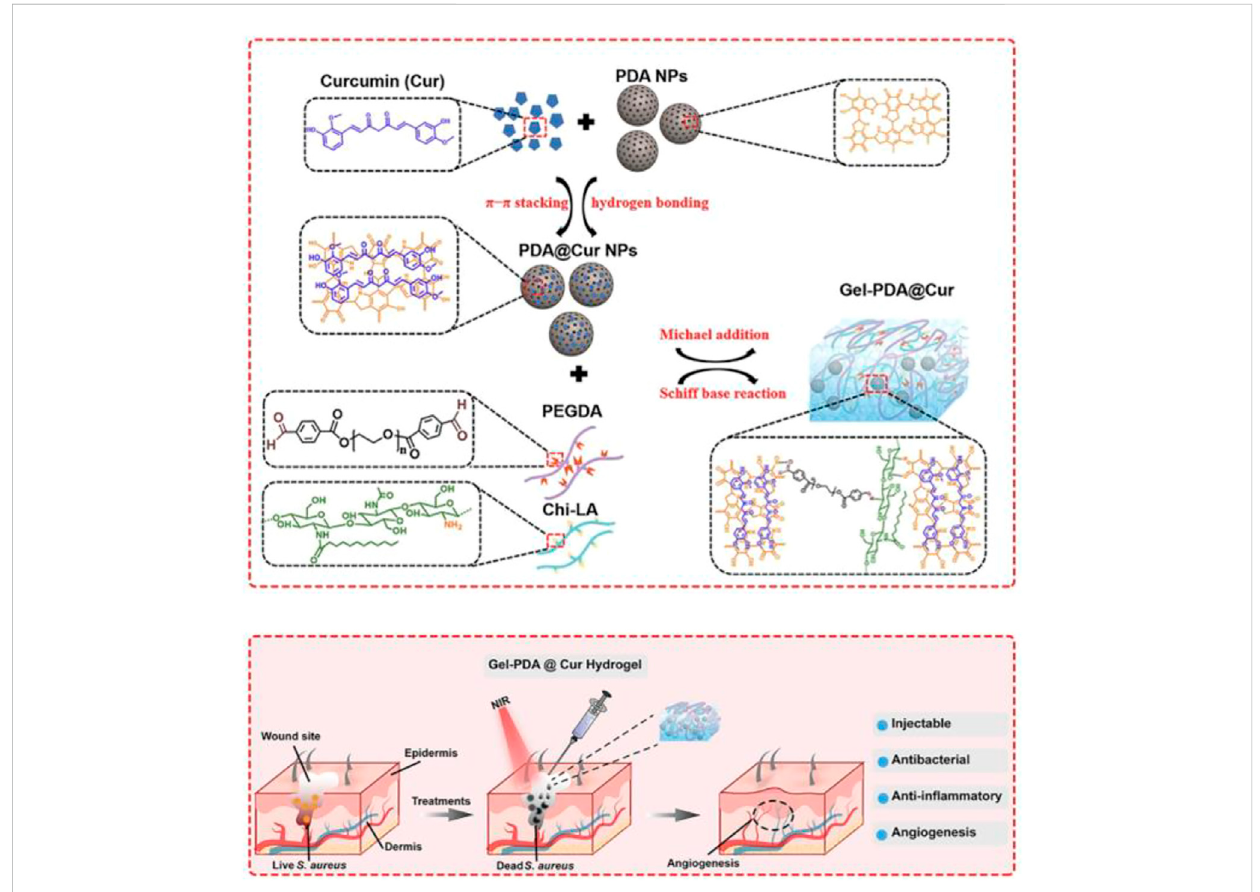
FIGURE 3 ynthesis route of Gel-PDA@Cur hydrogel and schematic representation of the fabricated hydrogel with NIR irradiation for bacterial inactivation to promote wound healing (Tao et al., 2021).